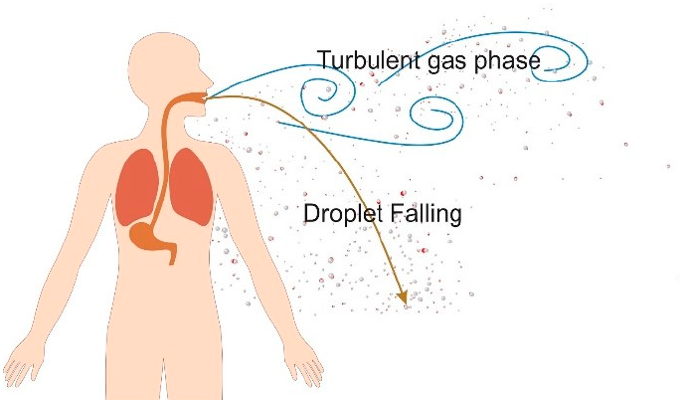
Figure 5. Transport of droplets in the air as a multi-phase